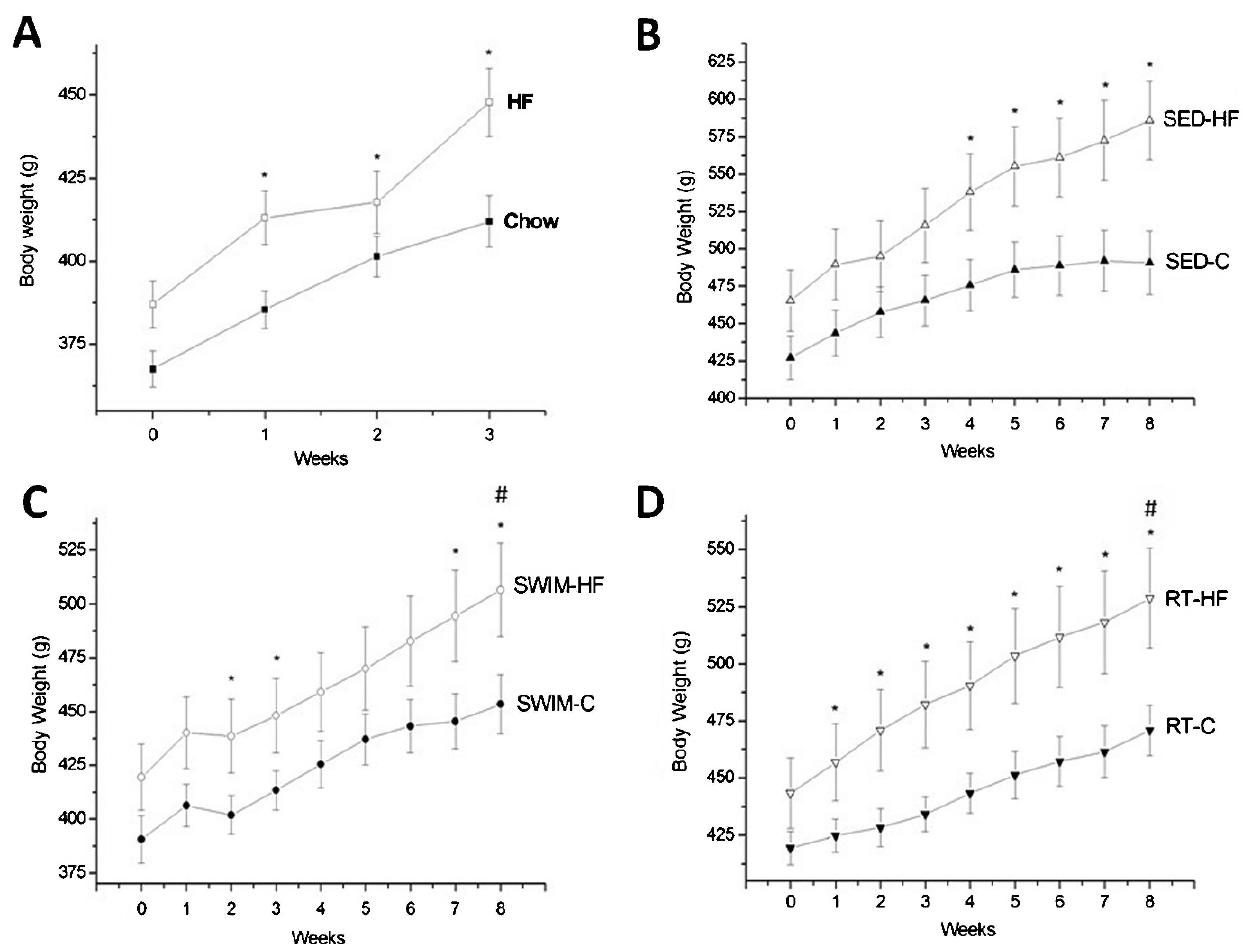
Figure 1 - Body weight evolution. All values are presented asmeans ¡ standard error of the mean; * p # 0.05 comparing before chow vs . high- fat diet (HF) 3weeks before the training period (A) and during training period (B, C and D); # comparing trained groups vs . sedentary groups during training period (B, C and D) ( n =10 each group). C, chow; HF, high-fat diet; Sed-C, sedentary chow; Sed-HF, sedentary high-fat diet; Swin-C, swimming chow; Swim-HF, swimming high-fat diet; RT-C, resistance training chow; RT-HF, resistance training